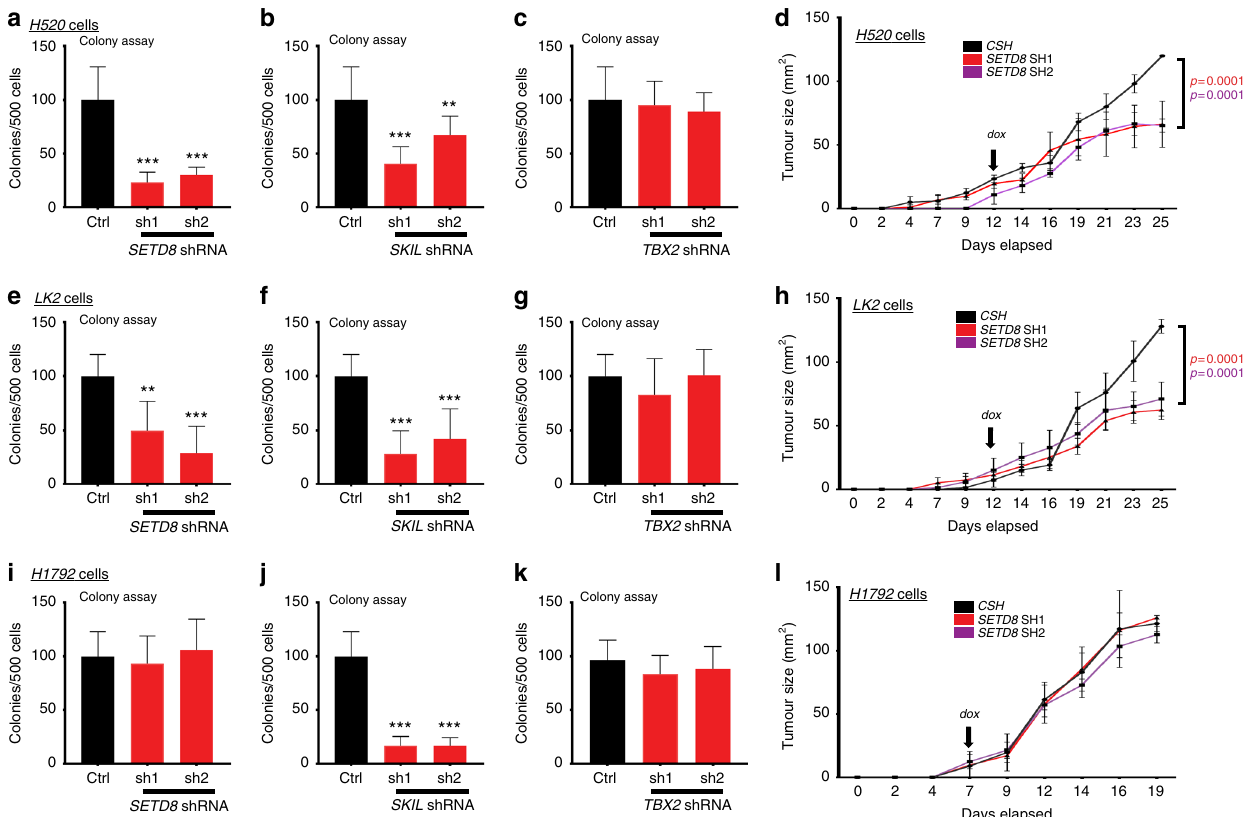
Fig. 5 SETD8-KD has a selective effect on LUSC cell line oncogenic capacity. a – c Comparison of colony numbers in 3D matrigel assay from control, shRNA1 or shRNA2 against SETD8 ( a ), SKIL ( b ) and TBX2 ( c ) in H520 cells. d Tumour kinetics of control or SETD8-KD H520 cells injected into immune compromised mice. Arrow indicates administration of doxycycline. e – g Comparison of colony numbers in 3D matrigel assay from control, shRNA1 or shRNA2 against SETD8 ( e ), SKIL ( f ) and TBX2 ( g ) in LK2 cells. Data presented as mean ± s.d. ( n = 3). h Tumour kinetics of control or SETD8-KD LK2 cells injected into immune compromised mice. Arrow indicates administration of doxycycline. i – k Comparison of colony numbers in 3D matrigel assay from control, shRNA1 or shRNA2 against SETD8 ( i ), SKIL ( j ) and TBX2 ( k ) in H1792 cells. Data presented as mean ± s.d. ( n = 3). l Tumour kinetics of control or SETD8-KD H1792 cells injected into immune compromised mice. Arrow indicates administration of doxycycline. Data presented as mean ± s.d. One-way ANOVA with post Dunnett test performed, * p < 0.05, ** p < 0.005 and *** p <